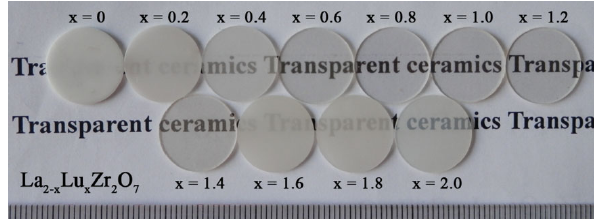
Fig. 18 Photograph of La 2– x Lu x Zr 2 O 7 ( x = 0–2.0) ceramics sintered at 1830 ℃ for 6 h in vacuum and annealed at 1500 ℃ for 5 h (1 mm thick). Reproduced with permission from Ref. [49], © Elsevier Ltd. 2014.